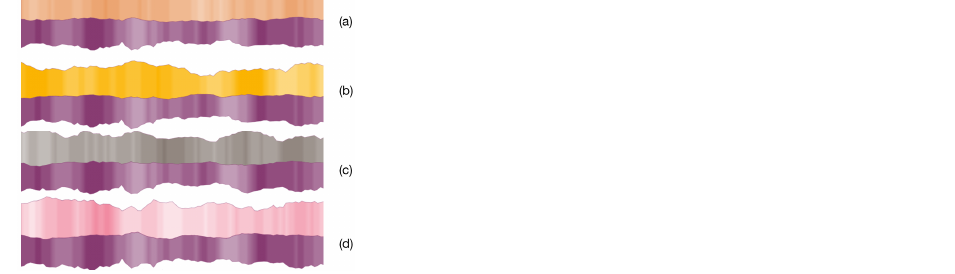
Figure 16. Using the merge component, compare pocket 1 with ( a ) pocket 2, ( b ) pocket 4, ( c ) pocket 6, and ( d ) pocket